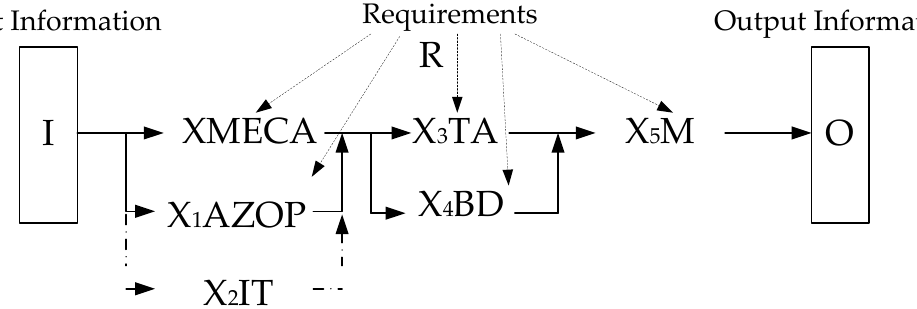
Figure 5. XMECA and other assessment techniques.